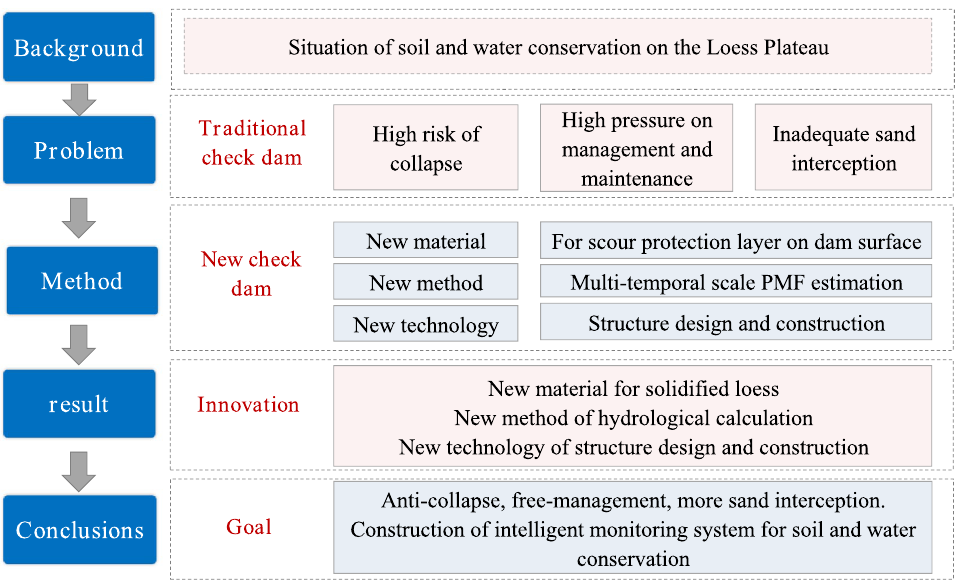
Figure 2. The research idea and technical route of this